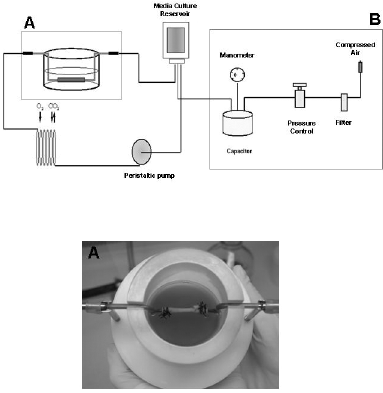
Figure 1 - Ex vivo perfusion system. Schematic representation of the system used for organ culture. It consists of a organ bath (A) , a peristaltic pump station and a pressure apparatus controller